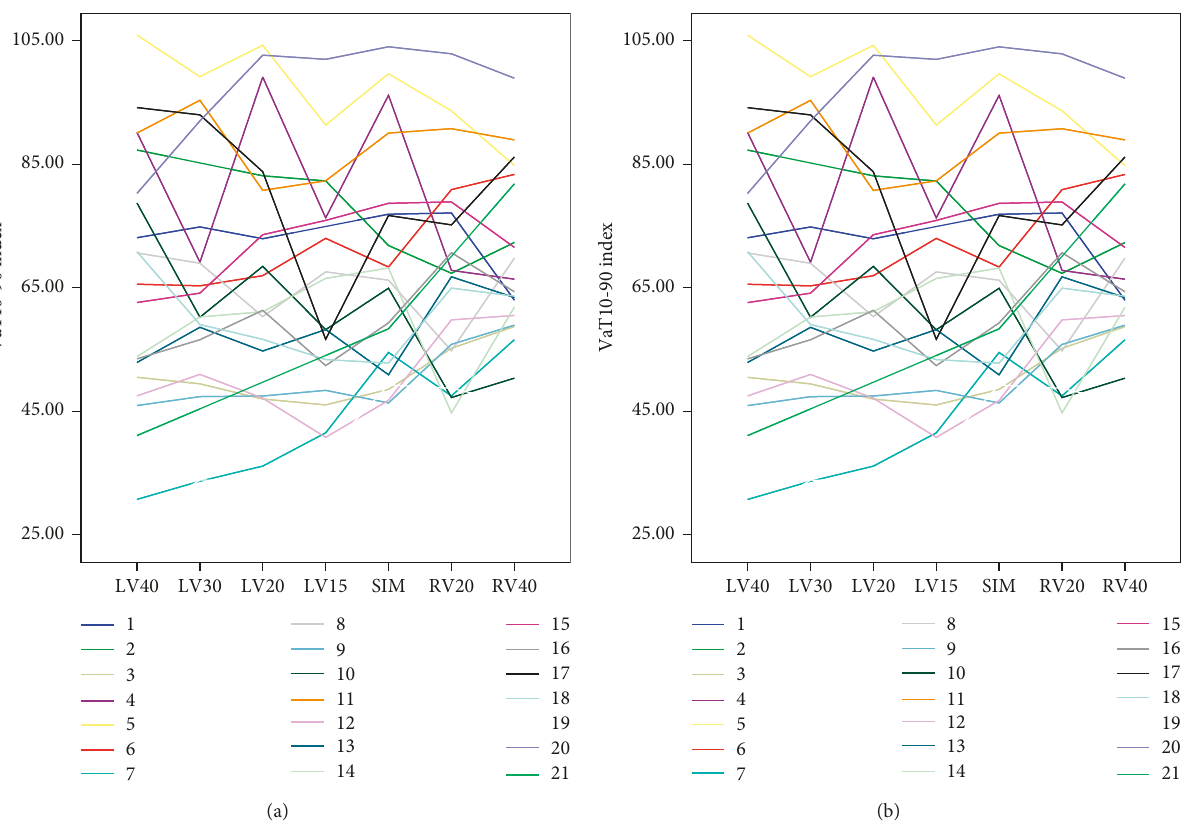
Figure 5: VaT 10-90 and TVaT values in each patient according to the VVD setting. LVx, intraventricular pacing interval with the left ventricle paced first by x milliseconds; RVx, intraventricular pacing interval with the right ventricle paced first by x milliseconds; SIM, intraventricular pacing interval with the right and left ventricles paced simultaneously; TVaT, total ventricular activation time; VaT 10-90 , ventricular activation time 10-90 .